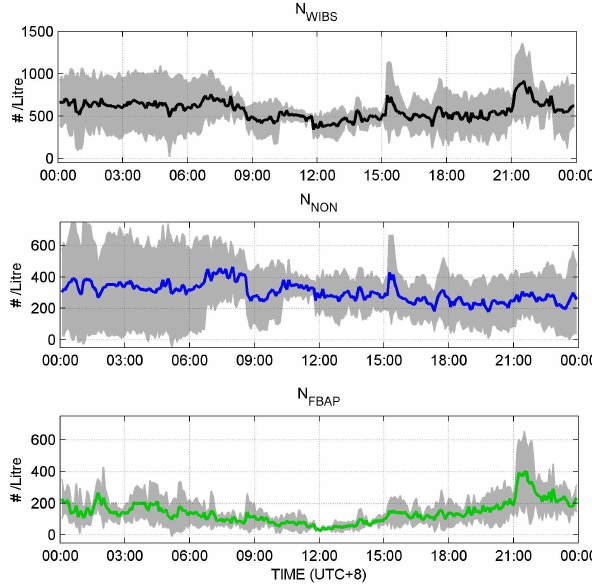
Fig. 10. Diurnal average of N WIBS , N NON and N FBAP at the above- canopy site. The shaded area represents ± 1standard